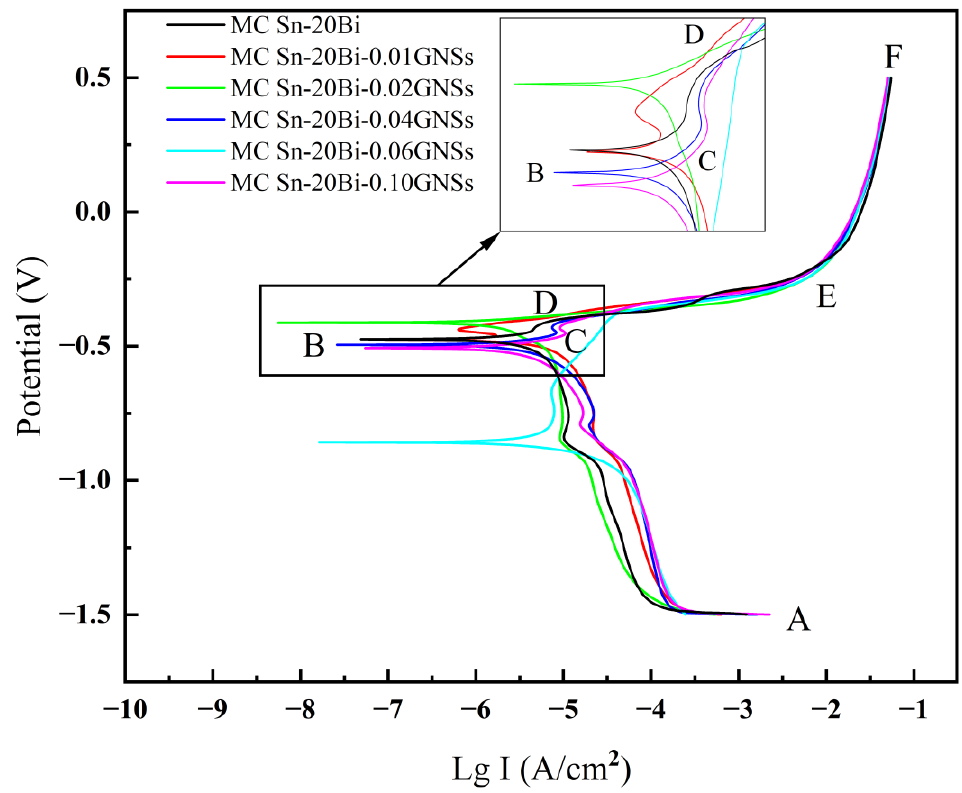
Figure 8. Polarization curves of MC Sn-20Bi- q GNSs alloys in 3.5 wt.% NaCl solution.